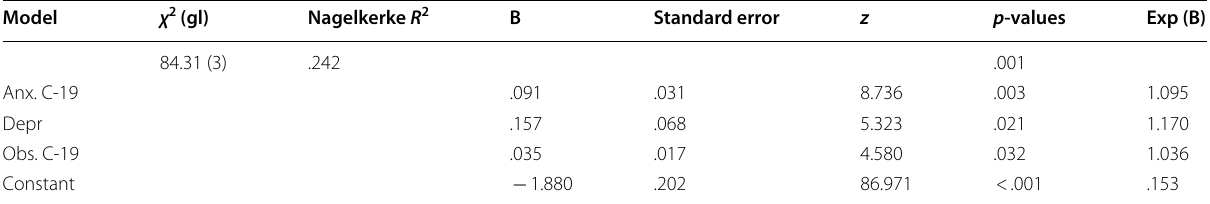
Table 5 Binary logistic regression predicting COVID‑19 pandemic